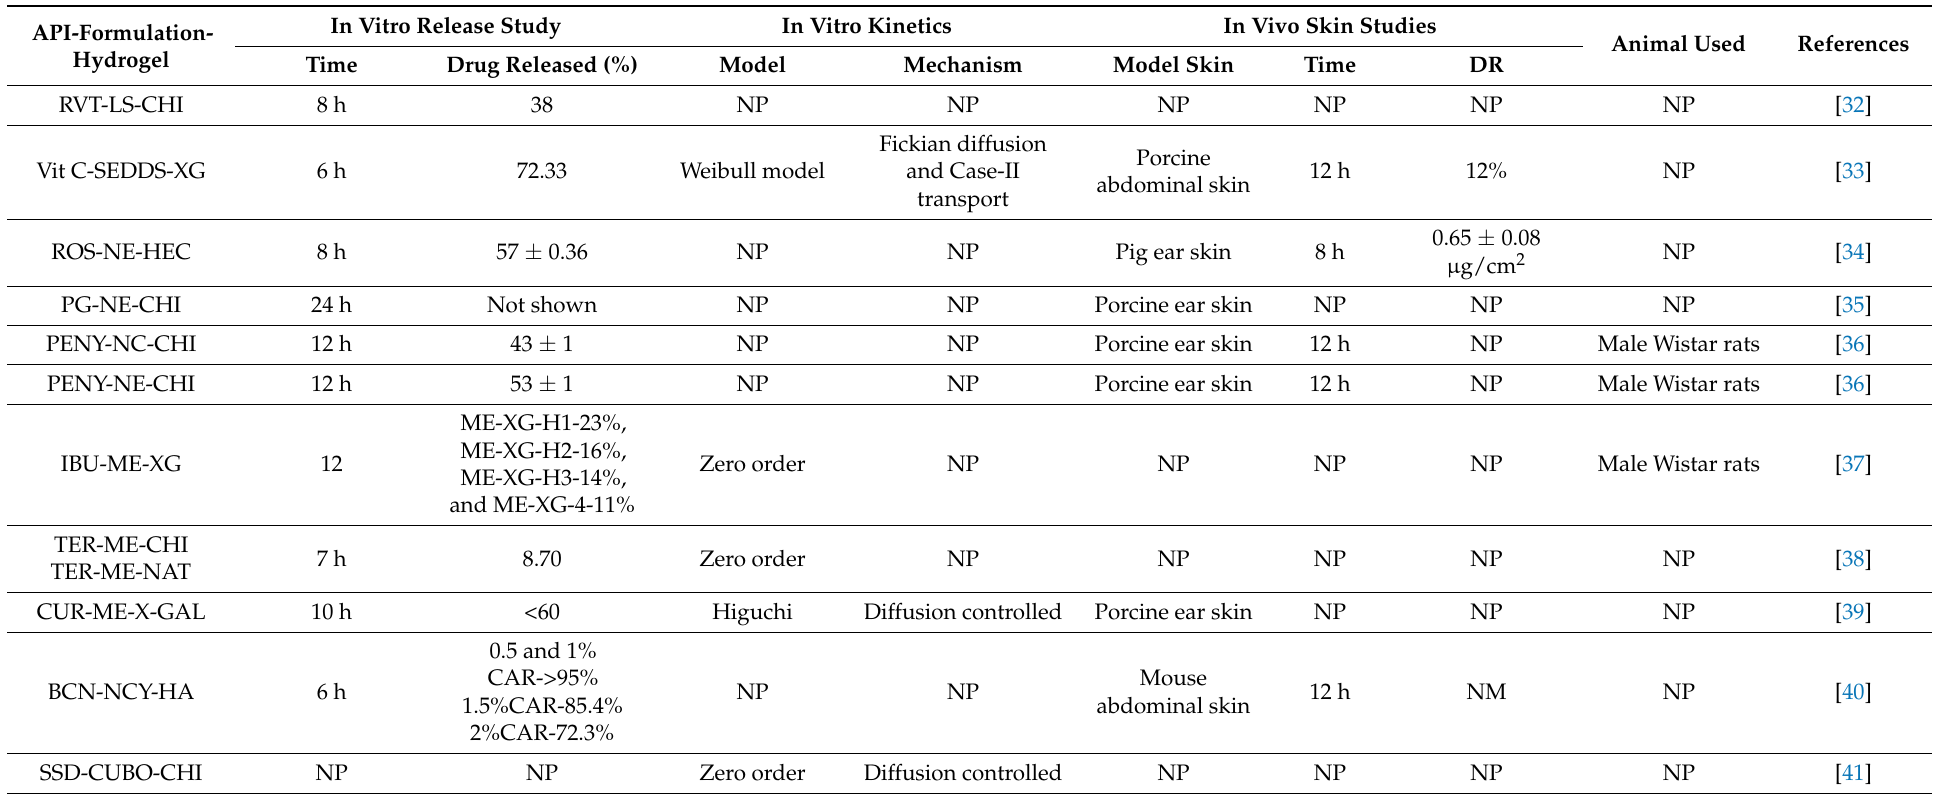
Table 4. Novel natural hydrogel formulation in vitro, in vivo evaluation studies